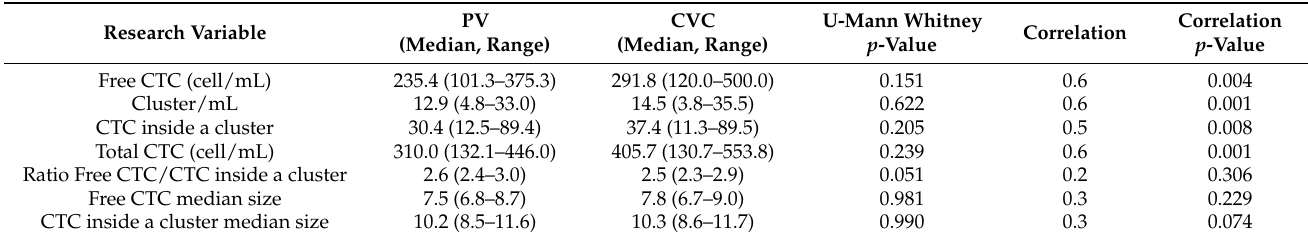
Table 1. CTC characterization by Hough transform method.